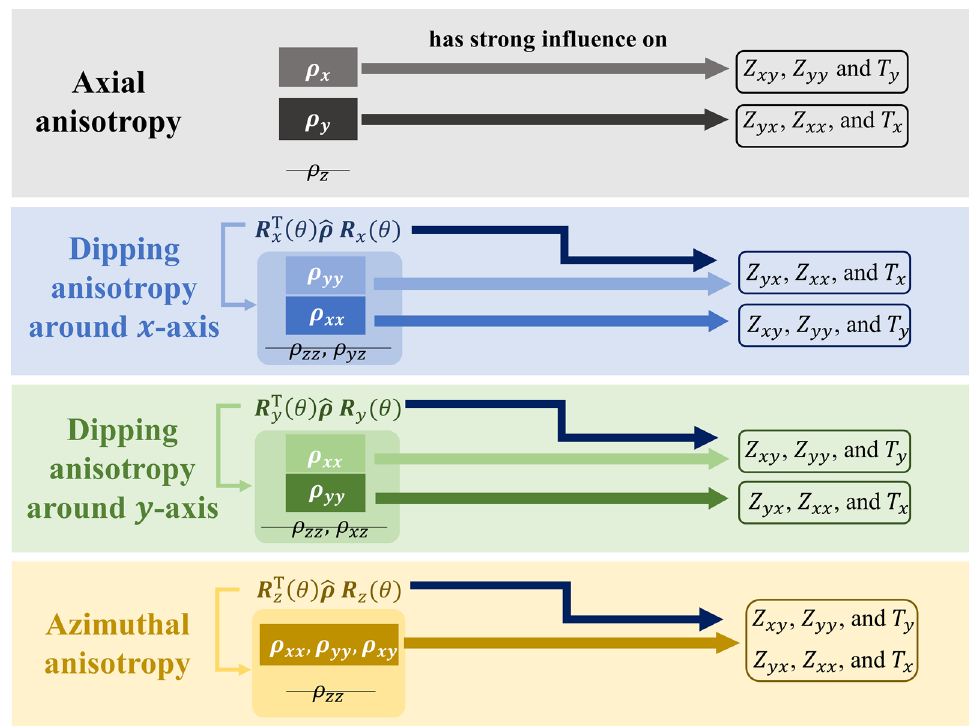
Fig. 12 A one‑page summary of our studies on the influence of the resistivity elements on the surface responses from the four anisotropic cases in sections. "The axial anisotropy"–"The azimuthal